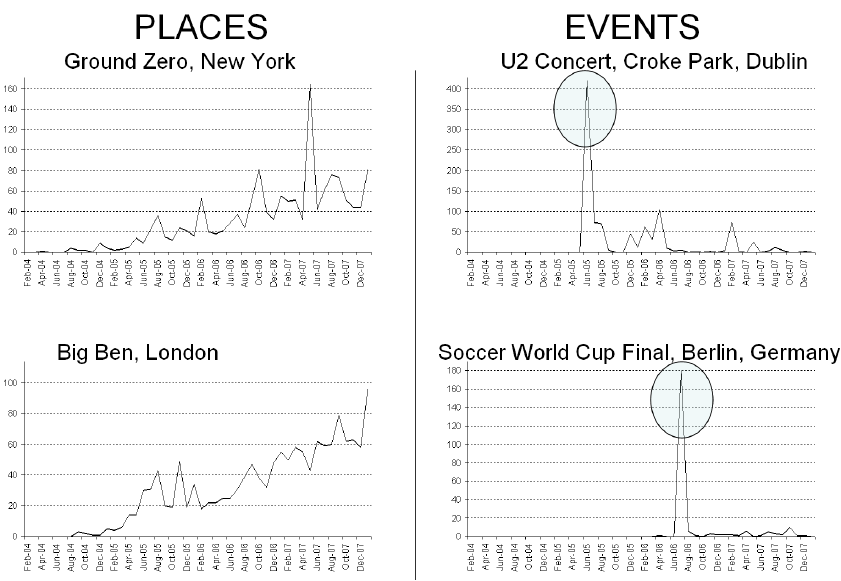
Figure 7. Characteristics of location-driven images vs . location+event-driven